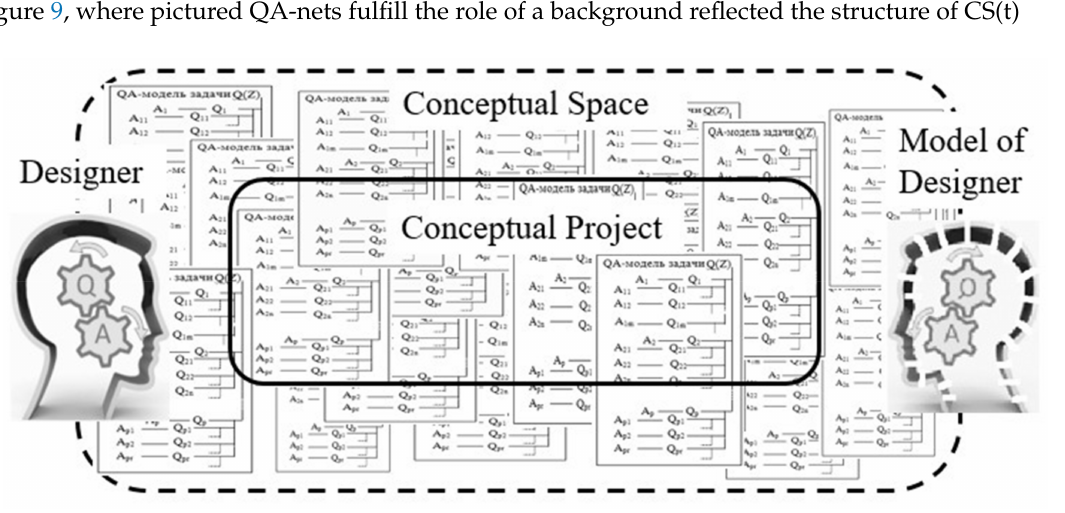
Figure 9. Interactions of the designer with nodes of